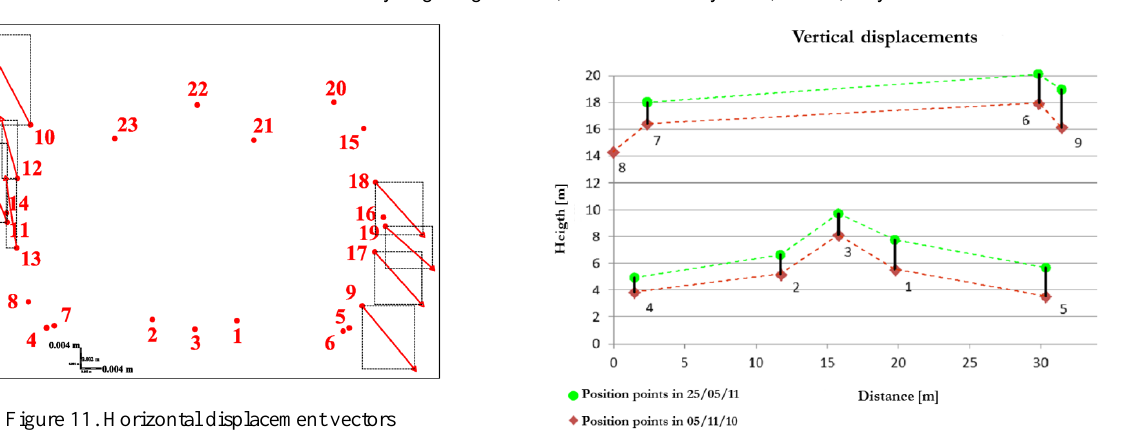
Figure 11. Horizontal displacement vectors